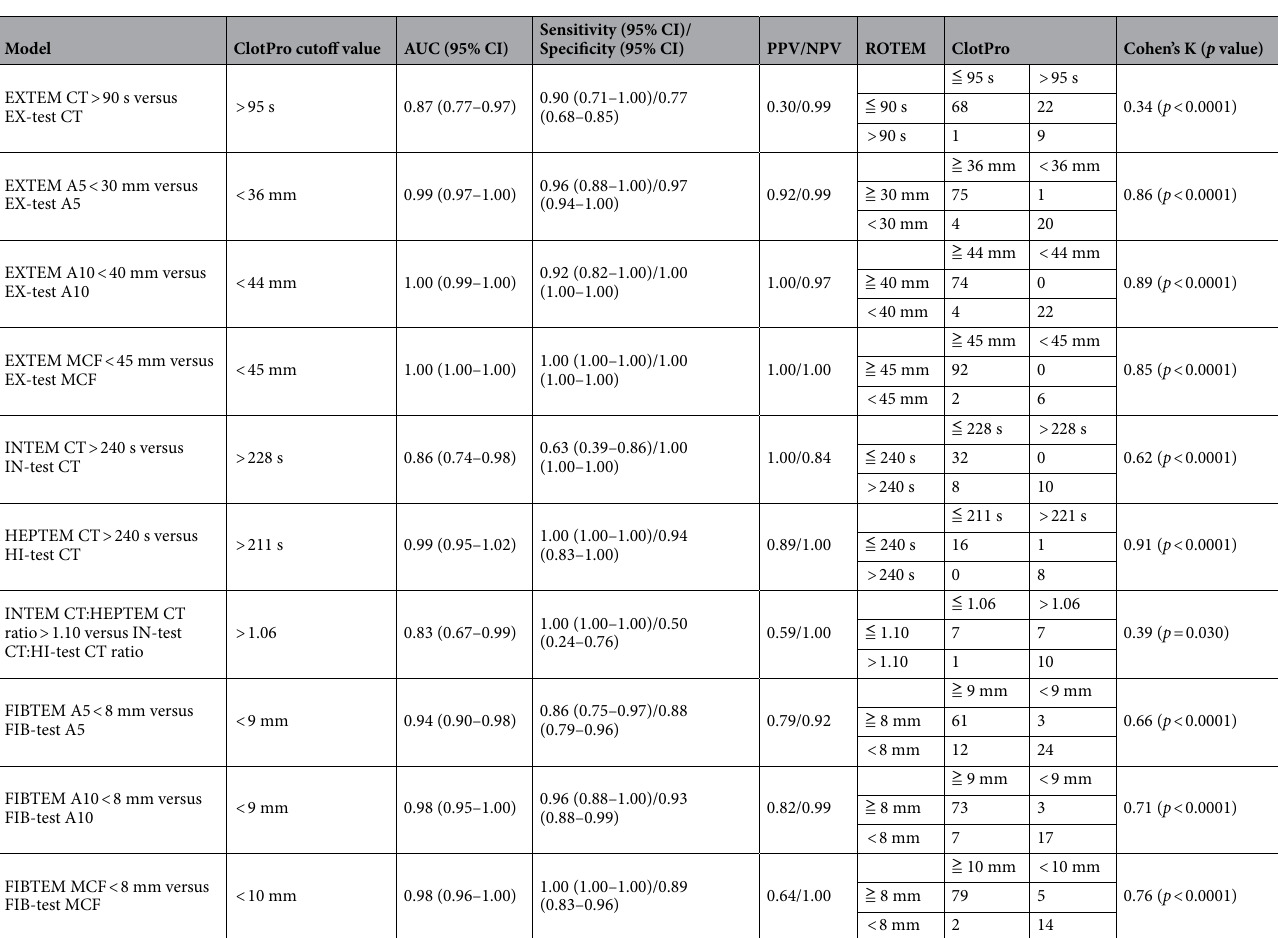
Table 3. ROC analysis of ClotPro parameters for various ROTEM thresholds. ROC receiver operating characteristic, AUC area under curve, 95% CI 95% confidence interval, PPV positive predictive value, NPV negative predictive value, CT clotting time, MCF maximum clot